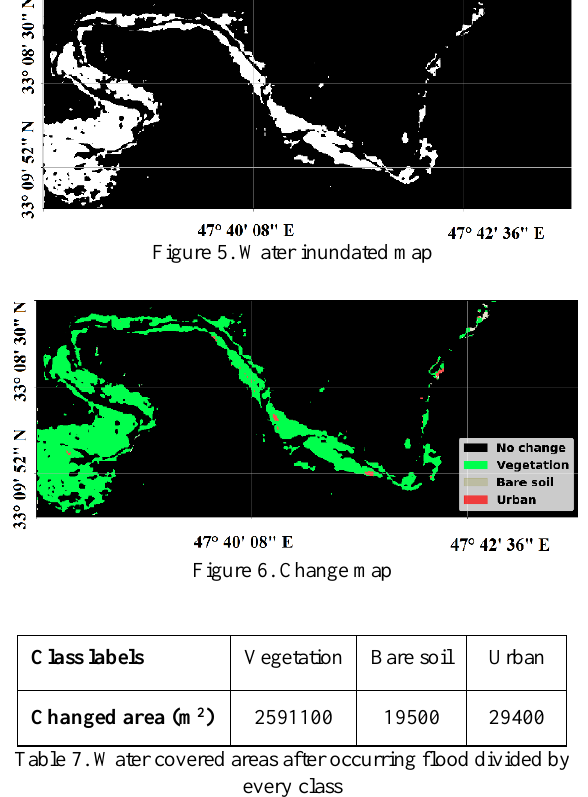
Table 7. Water covered areas after occurring flood divided by every